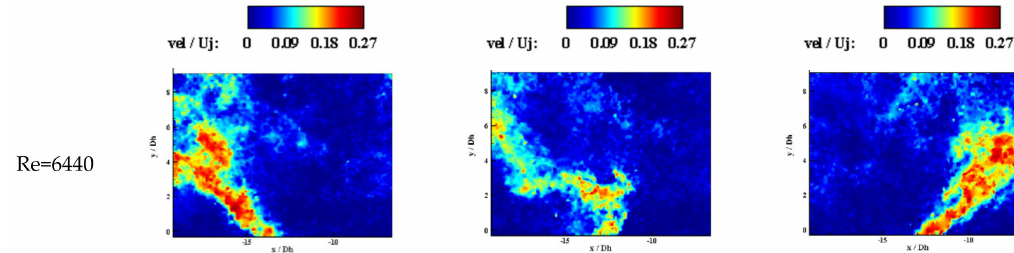
Figure 8. Instantaneous non-dimensional velocity magnitude for Re = 6440 in the free external